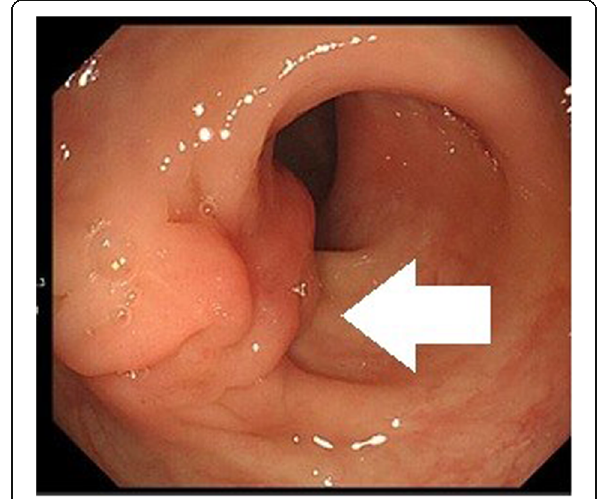
Fig. 7 Colonoscopy shows a 25-mm submucosal tumor in the sigmoid colon